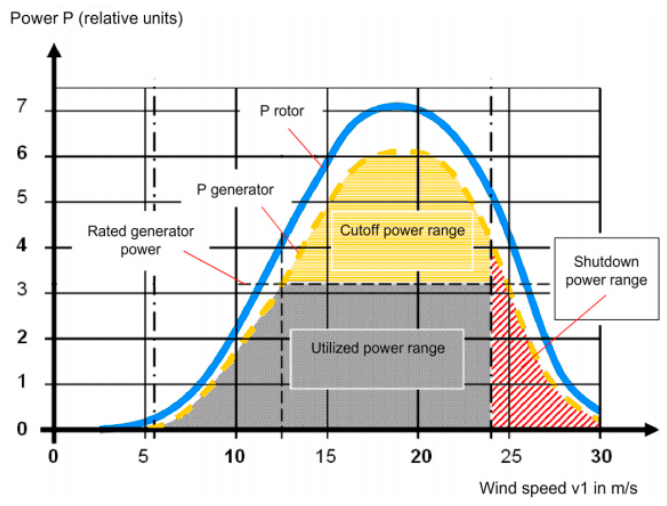
Figure 2. Control regions of blade-angle controller.